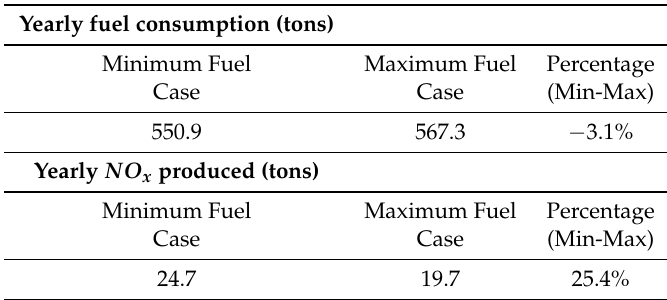
Table 5. The BSFC and NO x emissions